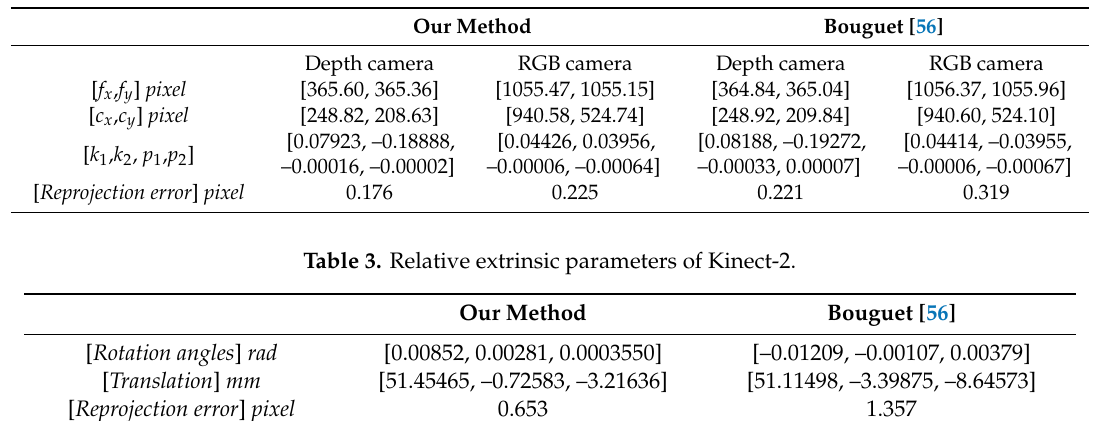
Table 2. Intrinsic parameters of Kinect-2.